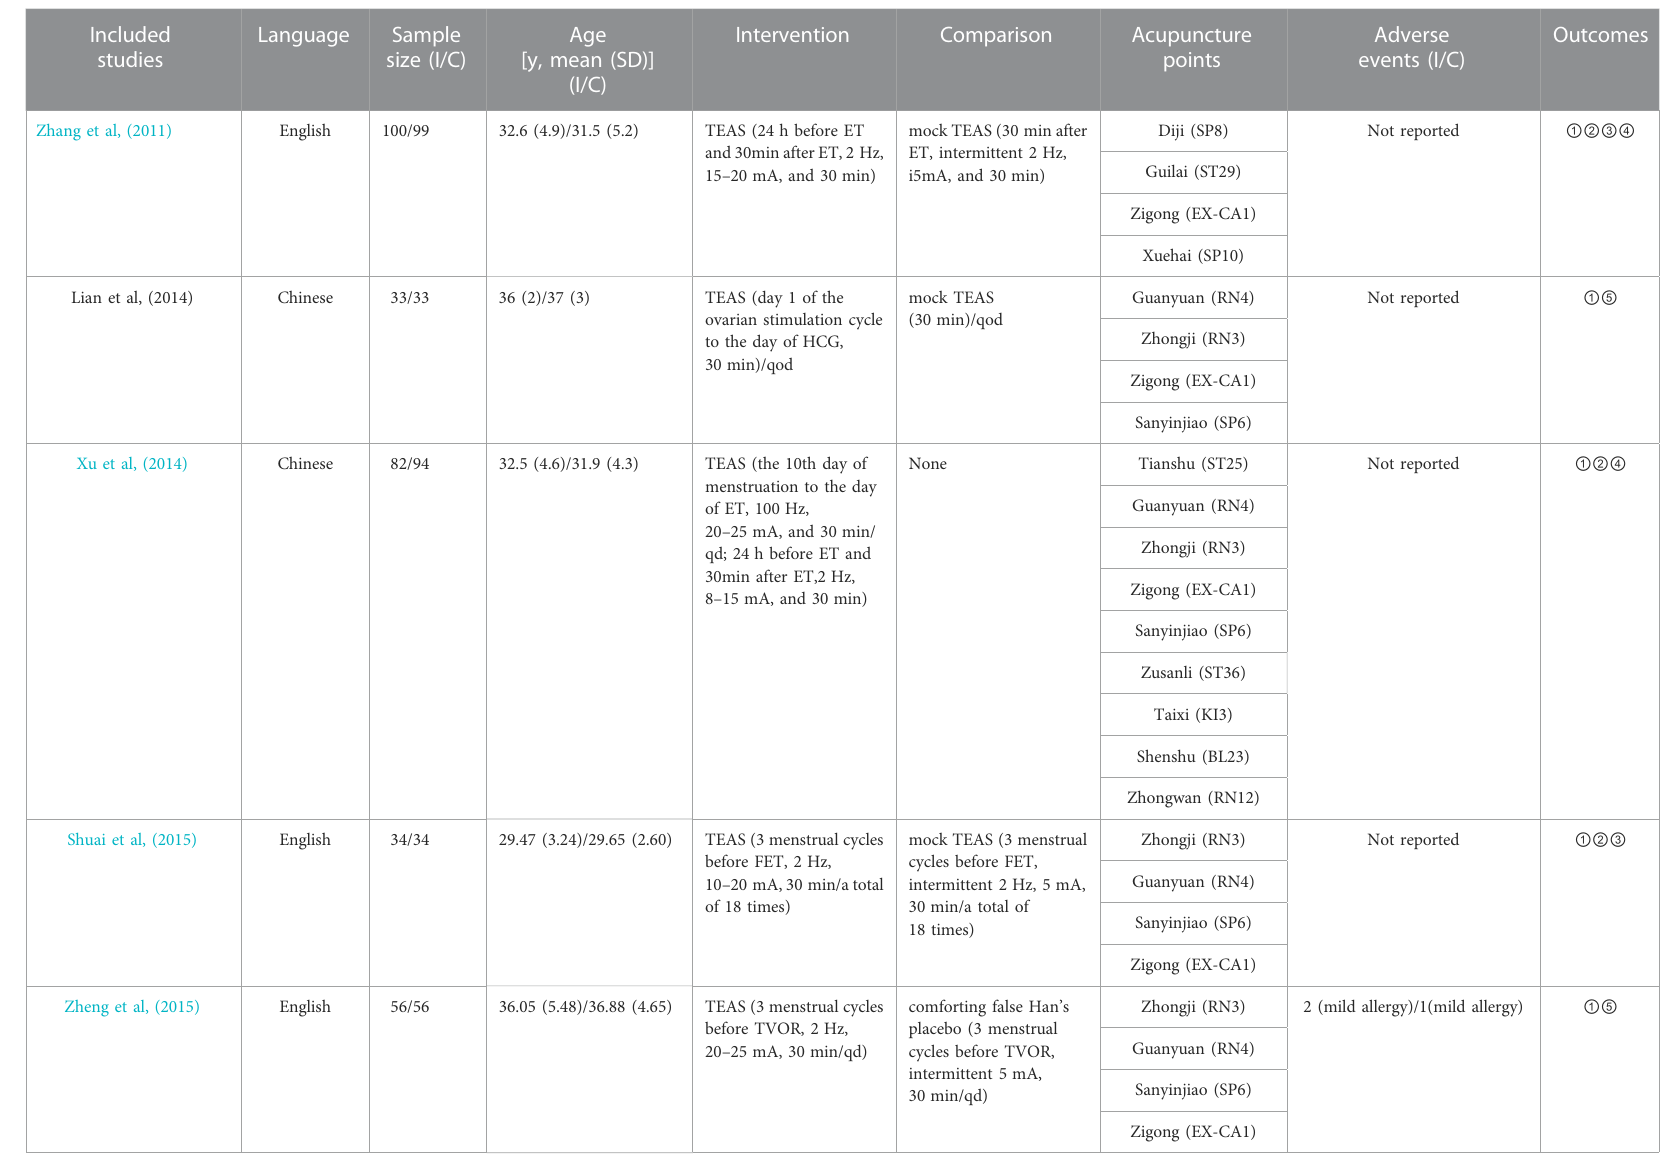
TABLE 1 Characteristics of included